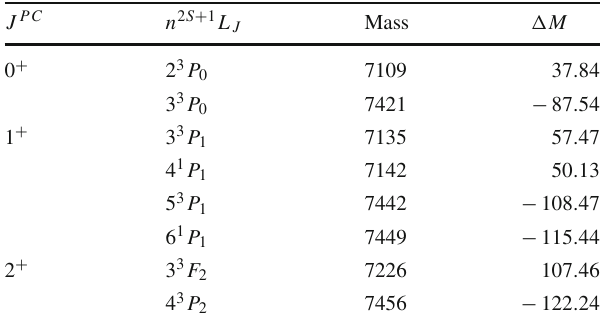
Table 3 Theoretical bare b ¯ c masses (in MeV) within ± 150 MeV from D ( ∗ ) B ( ∗ ) thresholds of Table 2, selected for the coupled-channels cal- culation. (cid:8) M ≡ M M (in MeV) shows the distance to closest thres − bare threshold (see Table 2)